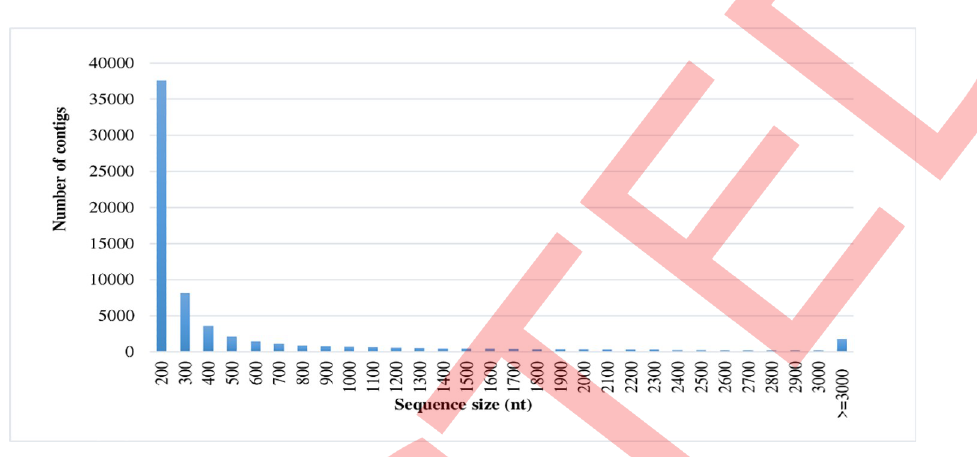
Fig 4. Length distribution of unigene sequences from transcriptome data of Rhynchophorus ferrugineus fat body tissues. Nucleotide sequence size (nt) and number of unigenes are shown on the X- and Y-axes, respectively.